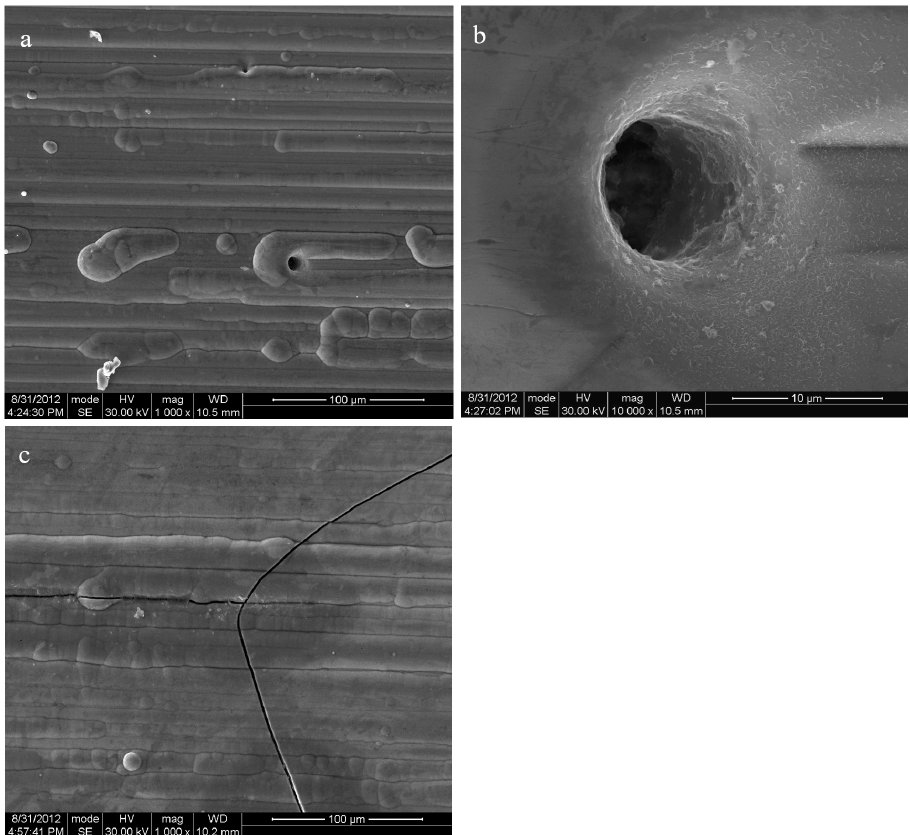
Figure 10. SEM micrographs of ordinary Ni coatings at various exposed time in 7 vol.% HCl solution. (a) 10 min, (b) higher resolution in Figure 10a, c 20